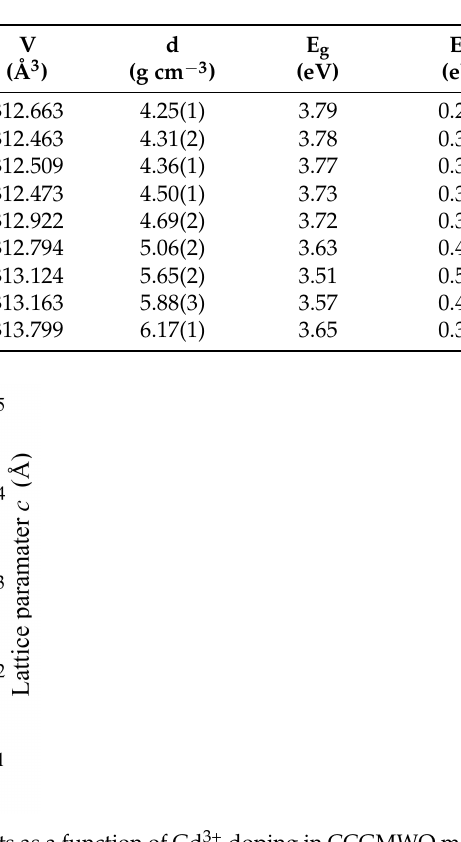
Table 1. Lattice constants ( a , c , and c / a ), volume of unit cell (V), experimental density (d), determined optical direct band gap (E g ), and Urbach energy (E U ) of CCGMWO solid solution.